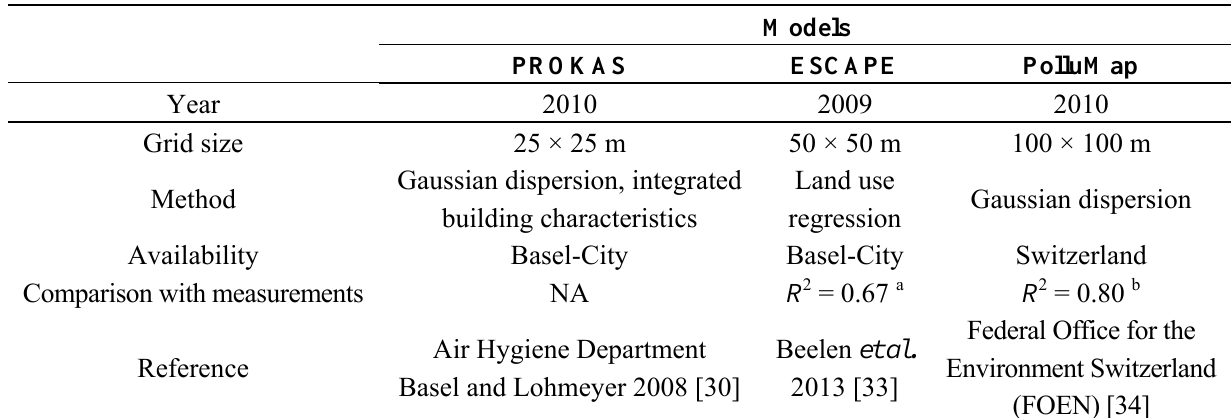
Table 1. Characteristics of the three air pollution models used to individually assign commute